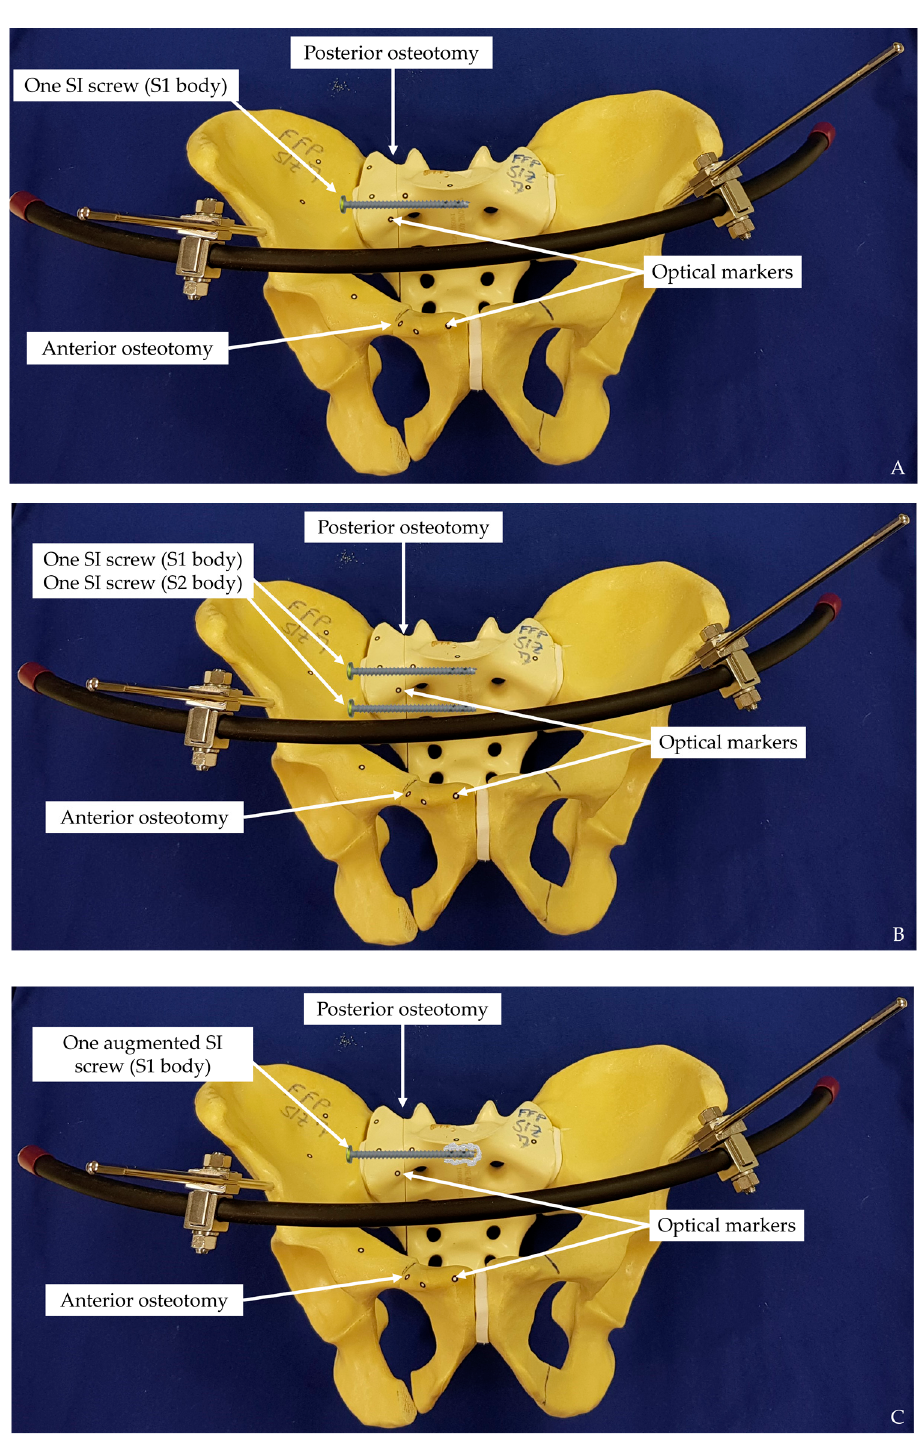
Figure 3. Exemplified specimens from each study group instrumented with either one SI screw (S1 body) (( A ), Group 1), two SI screws (S1 body and S2 body) (( B ), Group 2) and one augmented SI screw (S1 body) (( C ), Group 3).